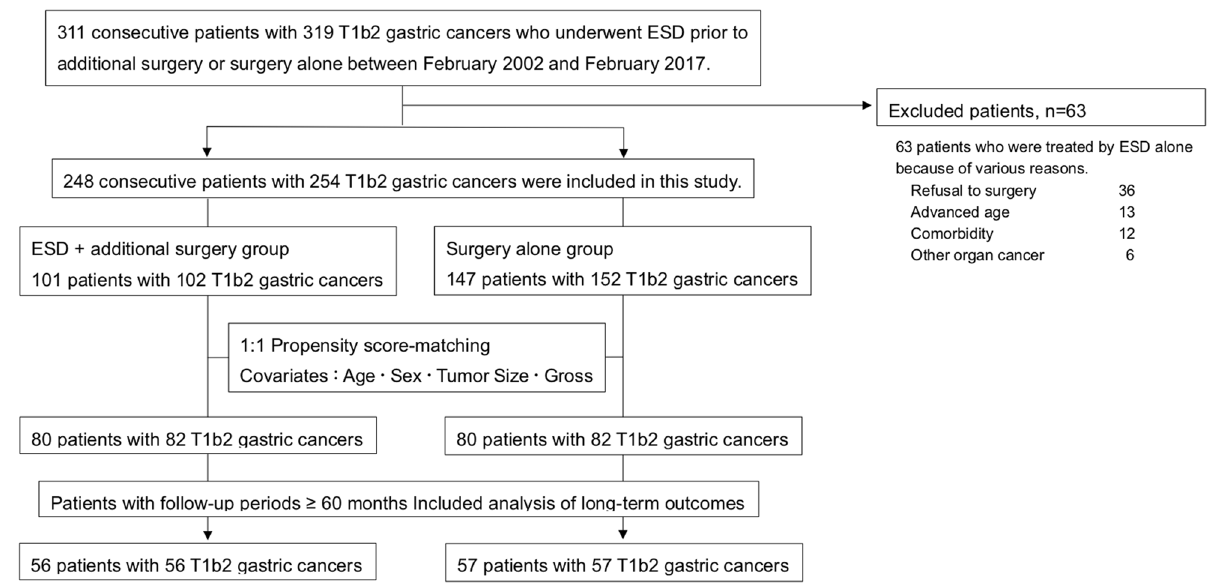
Figure. 1. This figure showed the flow chart of patients and tumors included in this study. T1b2 gastric cancer; depth of submucosal invasion ≥ 500 µm, ESD; endoscopic submucosal